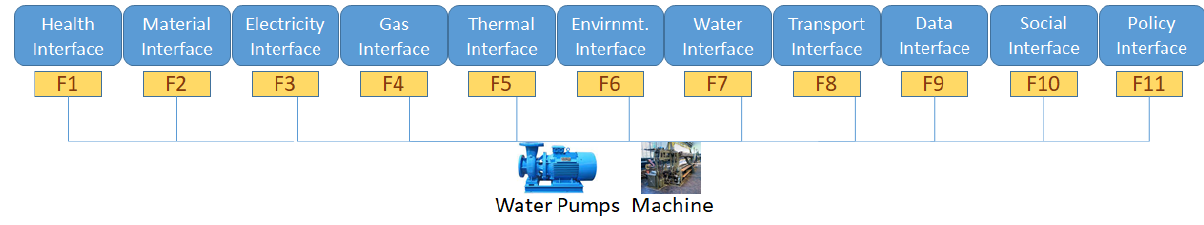
Figure 4. Interfaces with water pumps within interconnected infrastructures.